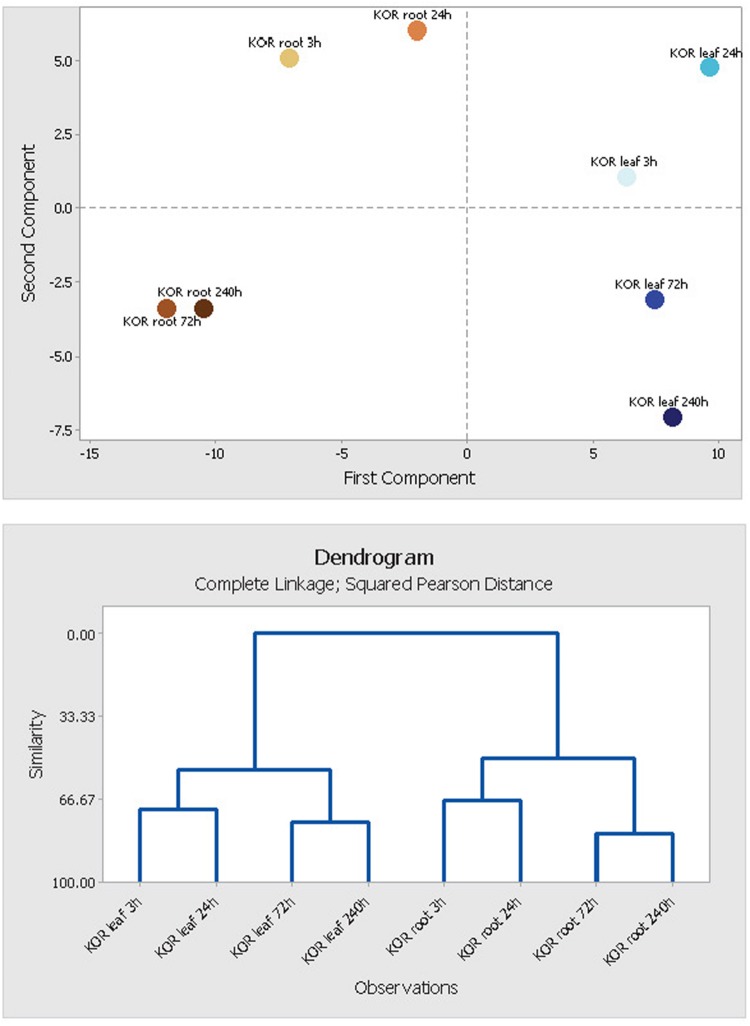
Principal component analysis (PCA) of leaf and root metabolite profiles. Segregation patterns of F. ananassa (KOR: cv. ‘Korona’) samples, harvested at different time points after cold treatment (0, 3, 24, 72, 240 h). The PCA diagram is based on 160 identified metabolites and non-identified mass spectral tags, and represents components PC1 × PC2 plotted against each other. PCA and tree clustering clearly indicate close similarity of metabolite profiles from time points 3 h/24 h and 72 h/240 h, and thus support the use of time point combinations for early (3 h/24 h) and late metabolic responses (72 h/240 h) being used in Figure 5 (metabolite network).